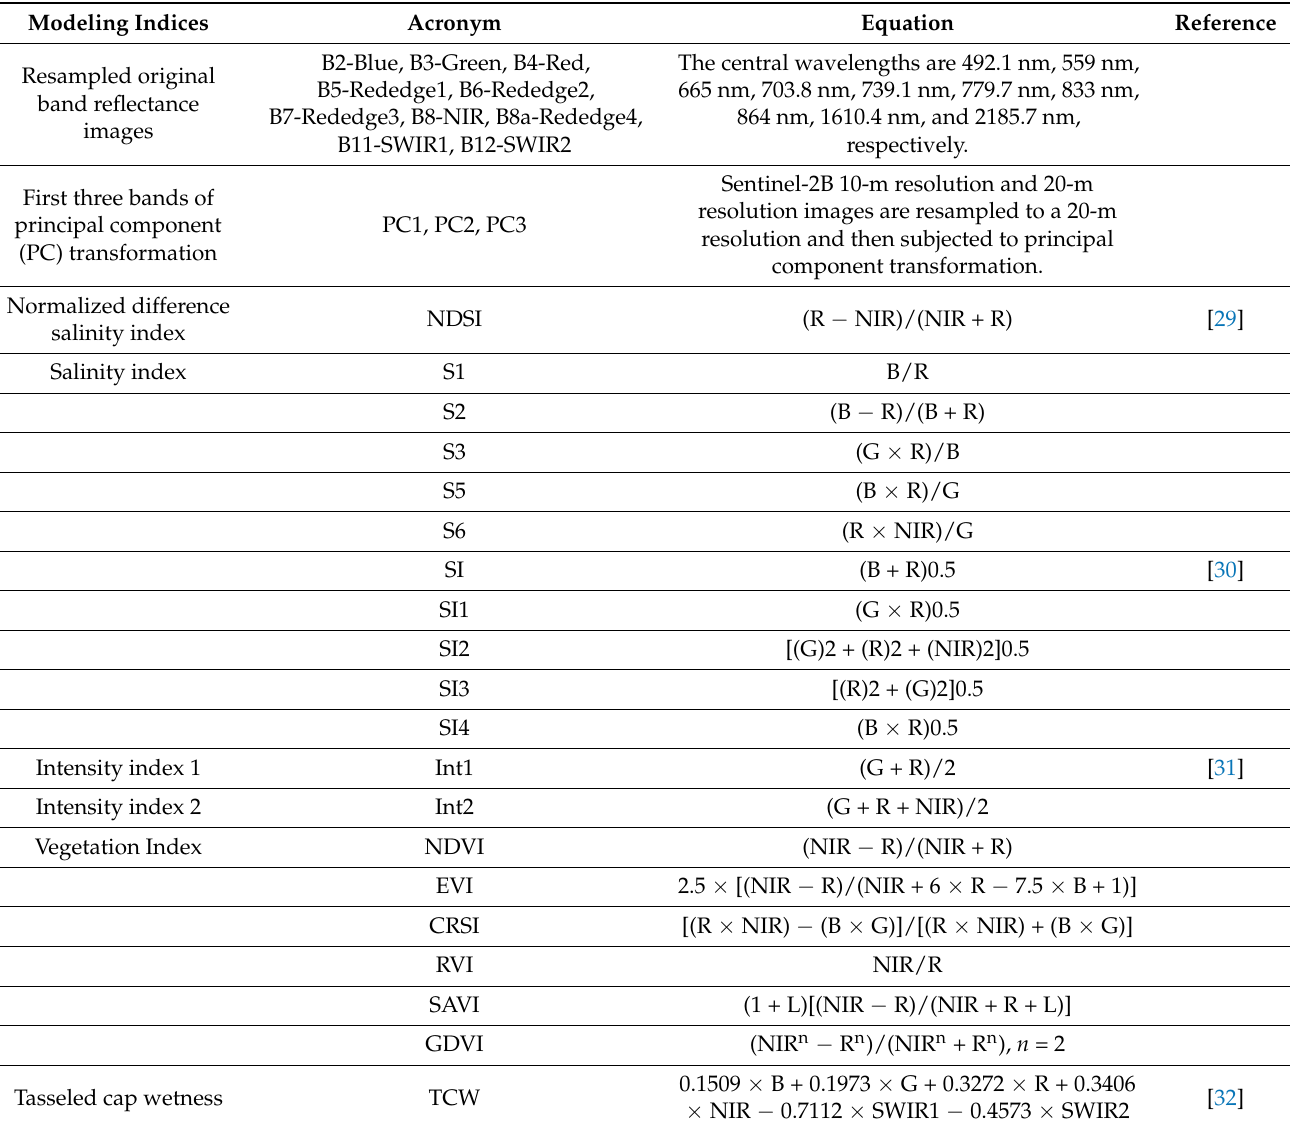
Table 1. Modeling indices used and their calculation